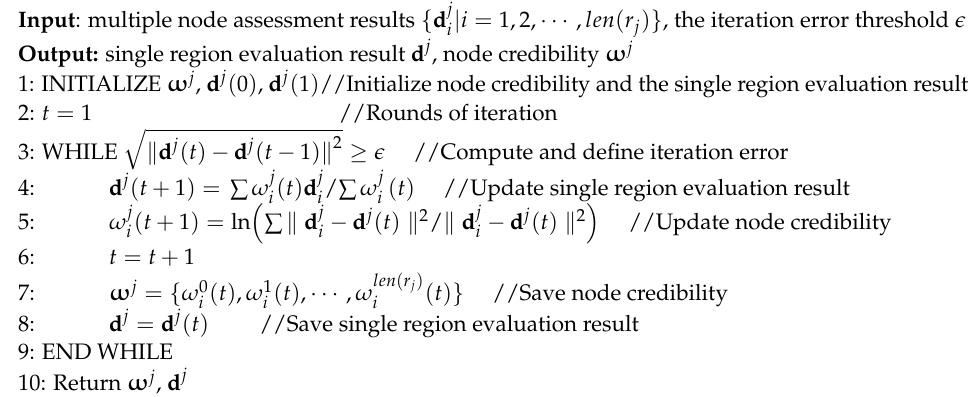
Algorithm 1 Local region evaluation algorithm based on node credibility